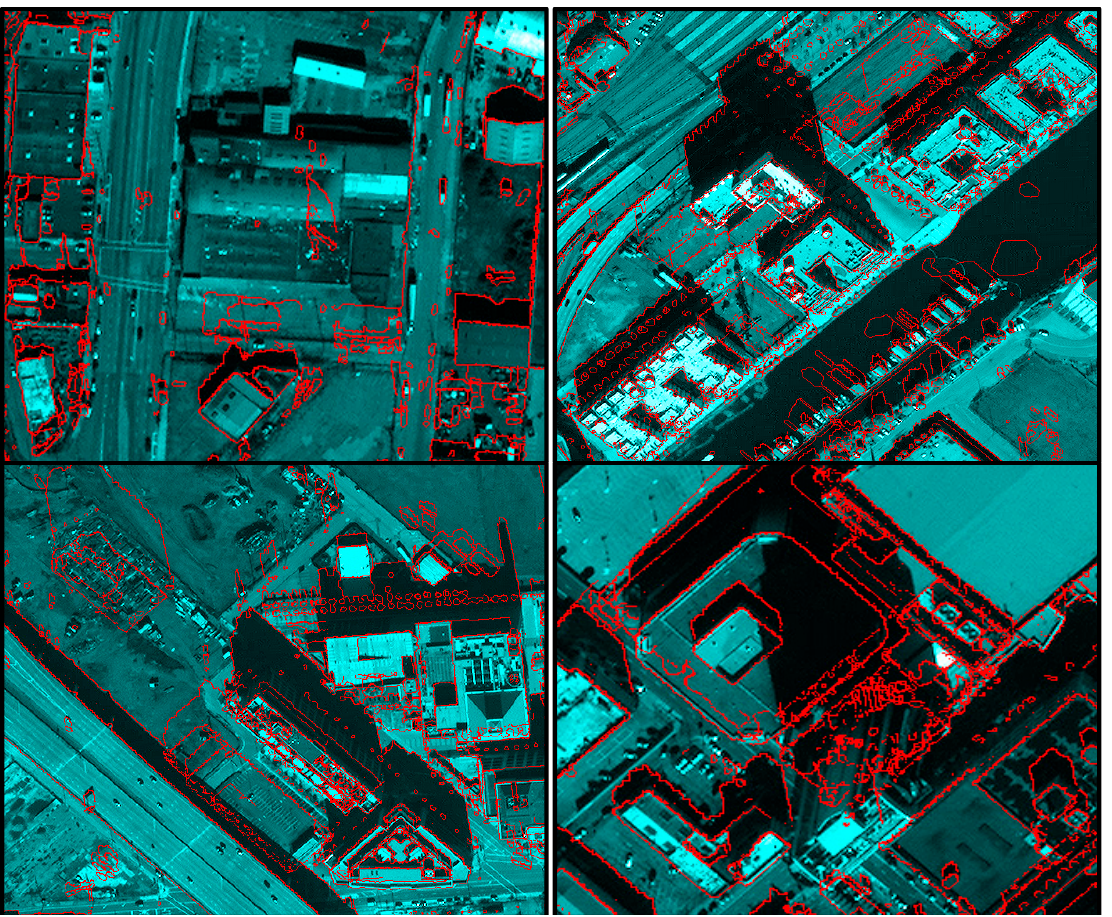
Figure 27. Samples of the PLS_Edges via the fine 3D model (red edges) superimposed on the HRSI in changed regions (similar regions with Figure 2).